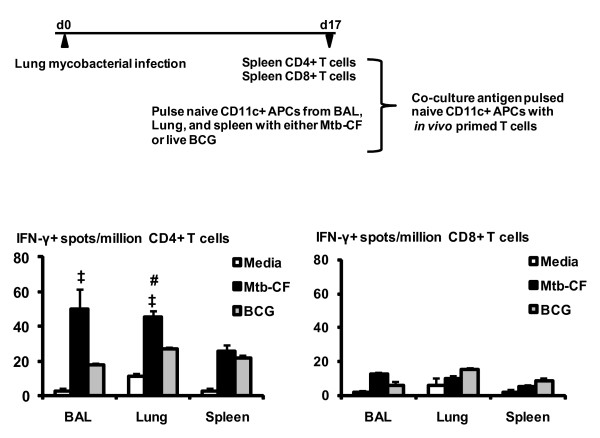
Ex vivo activation of in vivo mycobacterium-primed natural T cells by CD11c+ APCs from BAL, lung parenchyma and spleen. CD11c+ APC populations were isolated from BAL, lung parenchyma and the spleen and pulsed with M.tb CF protein or infected with live mycobacteria. APCs were then co-cultured with CD4+ or CD8+ T cells that were purified from the mice that were infected by live mycobacteria for 17 days (diagram). Cells were co-cultured for 24 h and IFN-γ-secreting T cells were determined by ELISPOT assay. A, IFN-γ-secreting CD4+ T cells. B, IFN-γ-secreting CD8+ T cells. Data are expressed as the mean value ± SD of triplicate samples and representative of two independent experiments. ‡p < 0.05 compared to the corresponding mycobacterial BCG-infected APCs; #p < 0.05 compared to the corresponding spleen data.